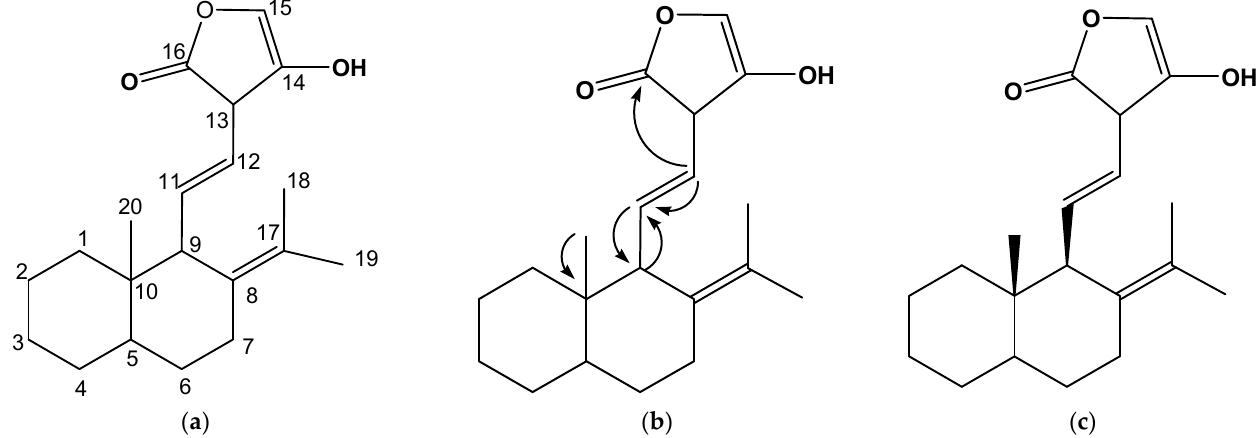
Figure 2. The numbered skeleton ( a ), the assigned HMBC ( b ), and the fully elucidated structure of compound 10-methyl-8-(propan-17-ylidene)naphthalen-9-yl)-11-vinyl-14-hydroxyfuran-16-one ( CF6 ) ( c ).